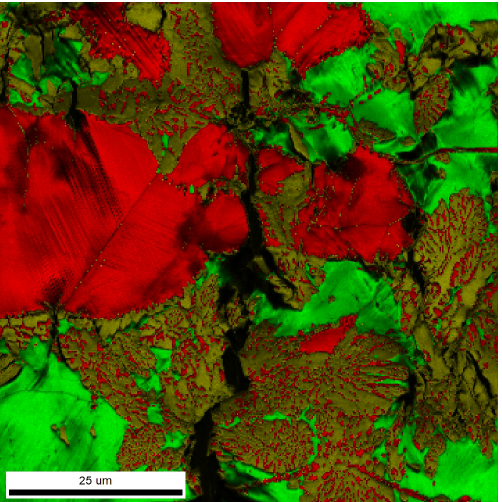
Figure 9. A close-up of the crack shown in the black circle in Figure 8b. This is a phase map with an IQ map overlay, acquired by EBSD. The red is austenite, green is ferrite and mustard yellow is σ -phase. The EBSD-scan of this area was acquired with a step size of 50